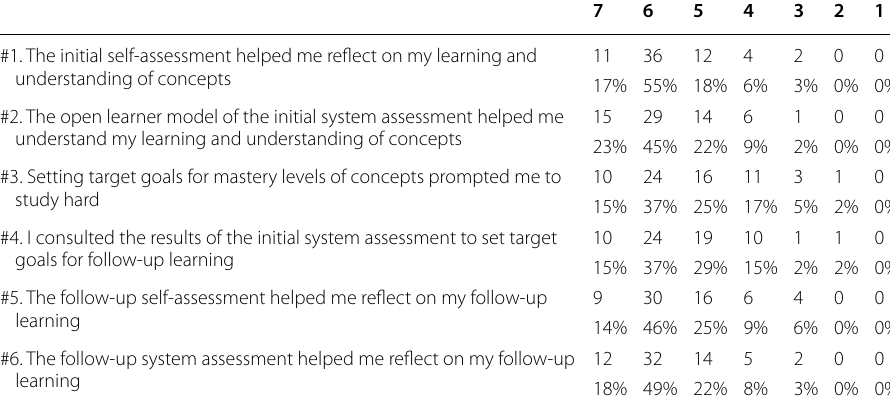
Table 13 Results of part 1 of the questionnaire